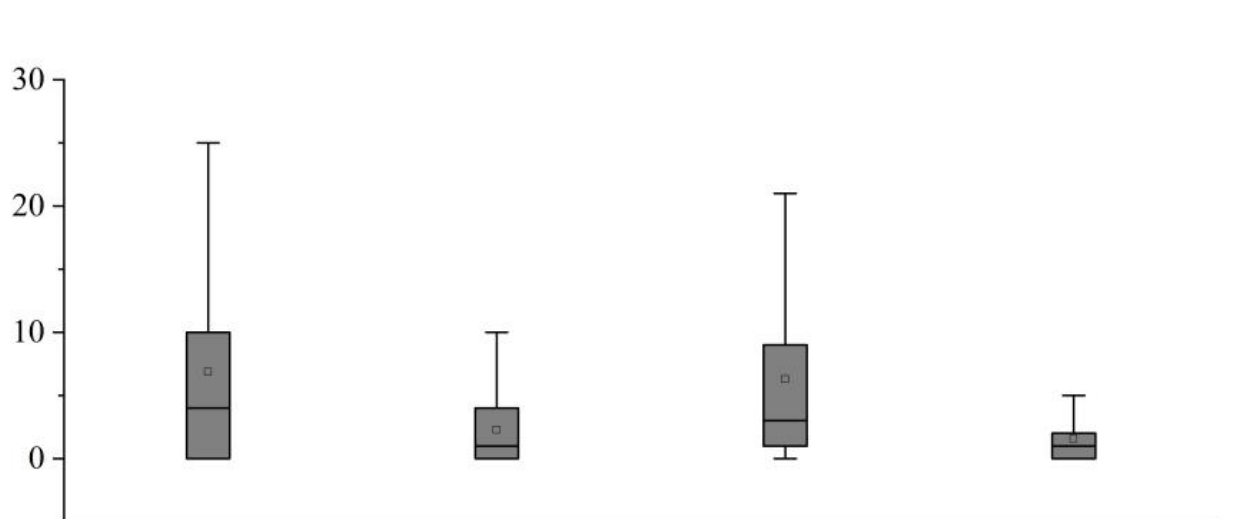
Figure 2. Boxplots of the residential burglary and non-motor vehicle theft count by day during the pre- (2019) and pandemic (2020) periods.